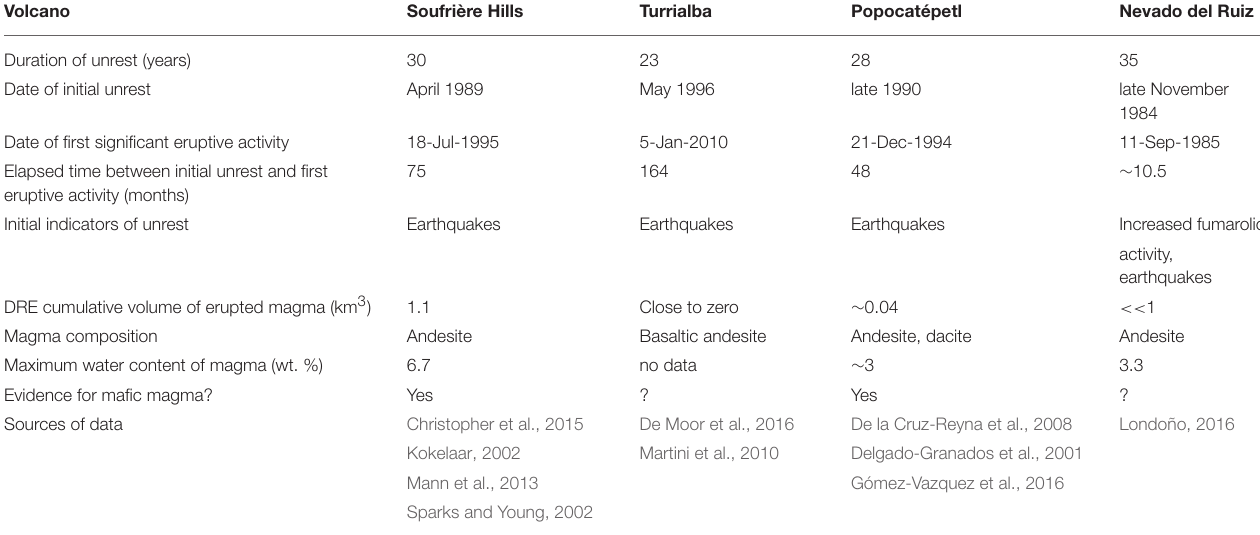
TABLE 2 | Characteristics of slow volcanic